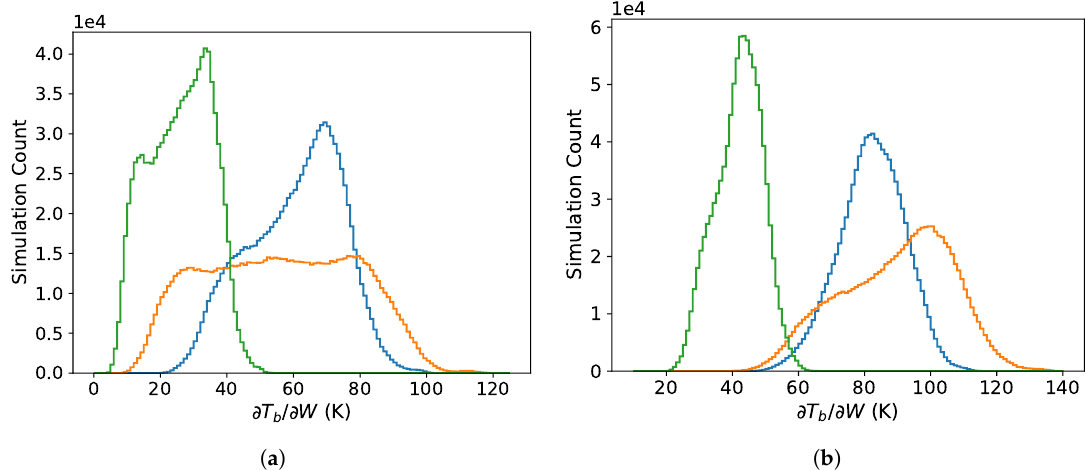
Figure 3. Distributions (simulation counts) of the sensitivity measure ∂ T B / ∂ W for 89 GHz at nadir (blue) and at EIA of 53 ◦ for V polarization (green) and H polarization (orange): ( a ) at the top of the atmosphere and ( b ) at the sea surface.